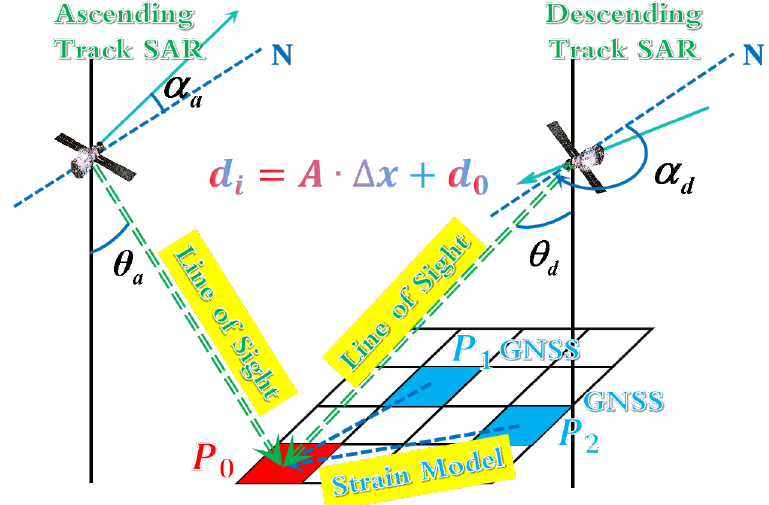
Figure 1. The strain model to fusion GNSS and InSAR measurements in the spatial